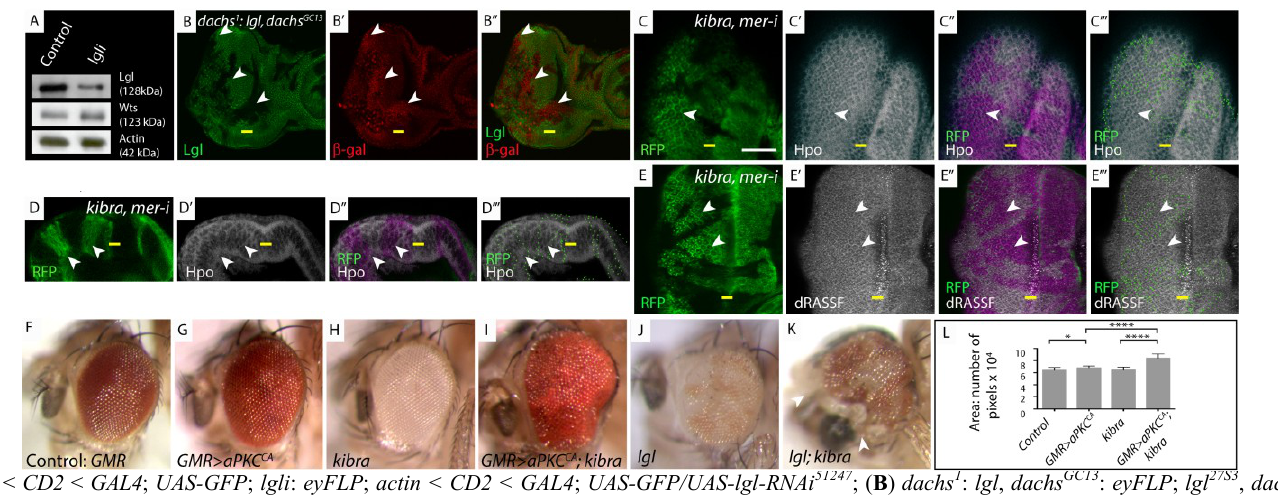
Figure 2. lgl regulates the Hpo pathway independently of Fat-Dachs and Kibra/Expanded/Merlin branches . ( A ) Western Blot showing Wts protein levels; ( B , C , E ) Planar sections of larval eye discs; ( D ) Sideview of larval eye disc. White scale bar represents 50 µM. Yellow bar denotes the morphogenetic furrow (MF), posterior is to the left in planar sections, in this and all other figures; ( F – K ) Adult female eye images; ( L ) Graphical representation of adult eye size presented in ( F – K ); ( A ) Western Blot analysis of protein extracts derived from control and Lgl depleted larval eye-antennal discs probed for expression of Warts (Wts). There is no change in Wts protein levels in lgl -depleted tissue; ( B ) dachs 1 : lgl −/− , dachs GC13/GC13 , diap1-lacZ mosaic discs stained for β-gal (red) show increased diap1-lacZ staining in lgl −/− , dachs GC13/GC13 clones (arrowheads). lgl −/− , dachs GC13/GC13 tissue identified by lack of Lgl antibody staining (green); ( C , C' , D , D' ) Hpo (white) and ( E , E' ) dRASSF (white) staining in kibra , mer-RNAi mosaic eye discs. In kibra , mer-RNAi tissue (RFP positive, green, mutant tissue indicated by arrowheads) Hpo and dRASSF concentration and localization are normal compared to wildtype tissue (RFP negative); ( C" – E" ) Overlay of RFP and antibody staining, pink highlights mutant RFP positive tissue; ( C''' – E''' ) Green dots outline RFP clone boundaries; ( F – K ) Reducing the level of kibra increases the size of GMR > aPKC CA or lgl −/− mosaic adult eyes; ( F ) Control adult eye; ( G ) GMR > aPKC CA adult eye; ( H ) kibra −/− tissue is white; ( I ) kibra −/− tissue that expresses aPKC CA shows synergistic increase in adult eye size; ( J ) lgl −/− mosaic adult eye ( lgl −/− tissue is white); ( K ) lgl −/− ; kibra −/− mosaic adult eye (double mutant tissue is white, arrowhead denotes head cuticle tissue); ( L ) Quantification of adult eye size ( F – K